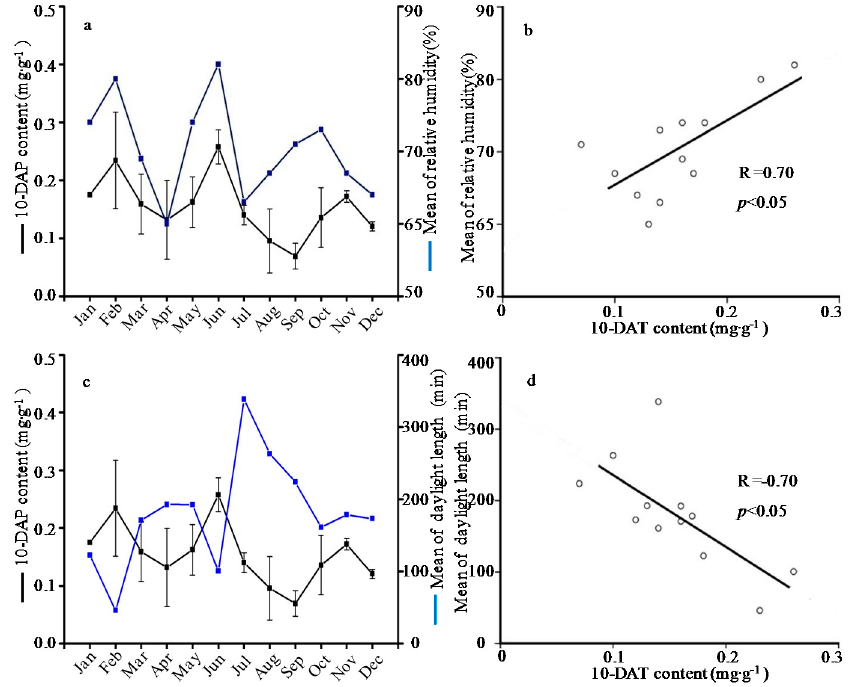
Figure 3. Relationship ( a ) and correlation ( b ) between 10-deacetyltaxol (10-DAT) content and mean of relative humidity; and relationship ( c ) and correlation ( d ) between 10-DAT content and mean of daylight length.